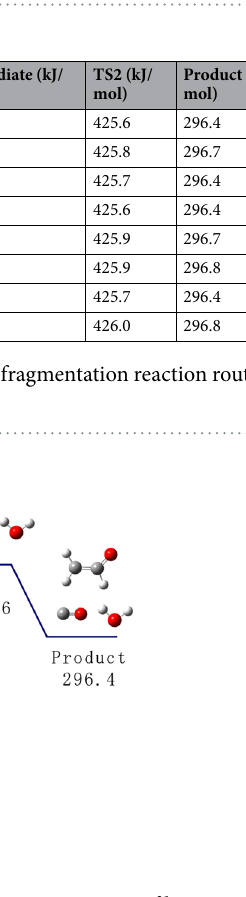
Reactant (kJ/ mol)